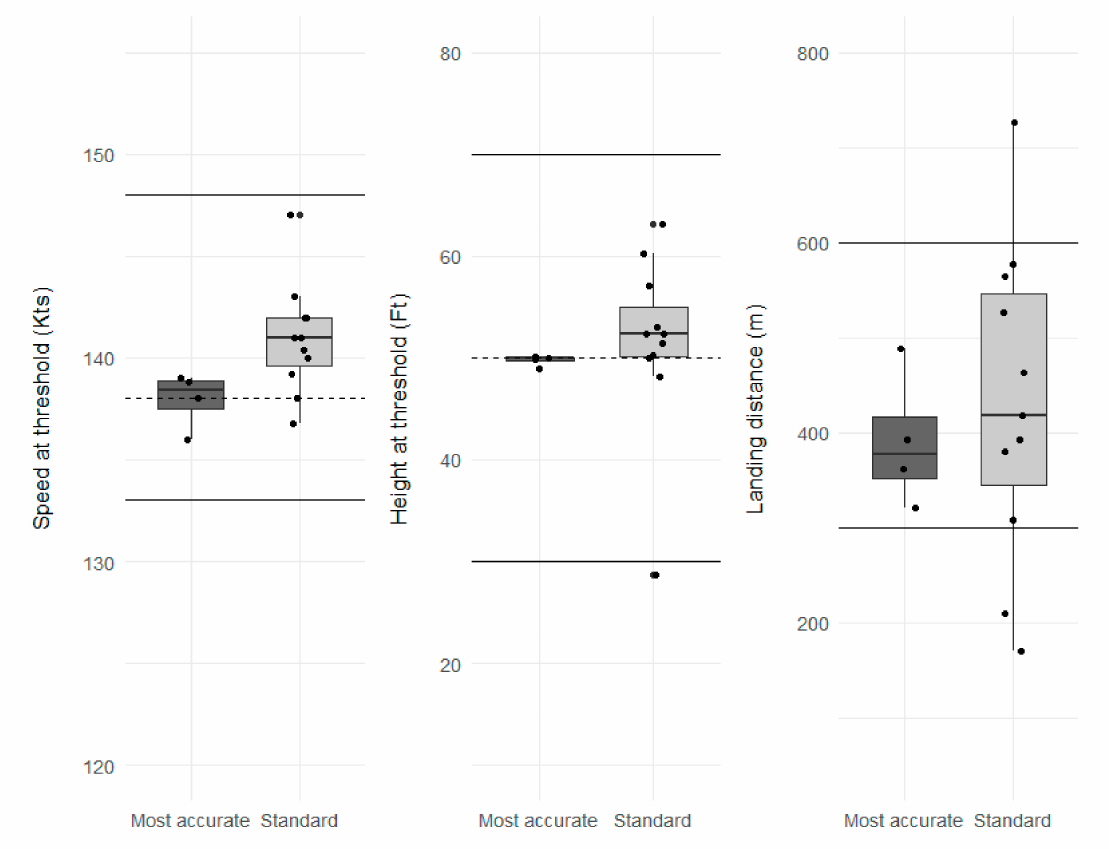
Figure 6. Additional flight performance during the approach (pre-training session). Mean speed, height, and landing distance for the 15 pilots (accurate and standard pilots) who successfully performed a stabilized approach (dots represent individual data). Solid lines indicate parameter tolerances for meeting stabilization and represent accepted limitations. The dashed lines indicate target speed and height. The 5 unstabilized pilots are not represented since they aborted the